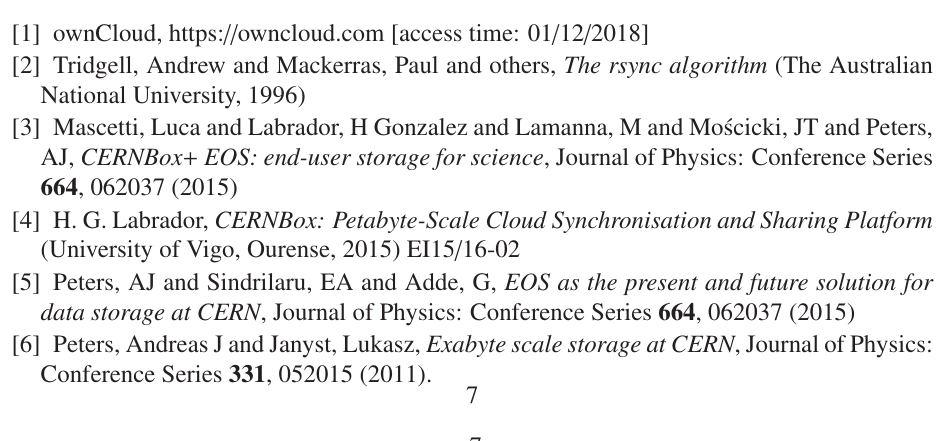
Figure 9. Integration of CERNBox with the SWAN service